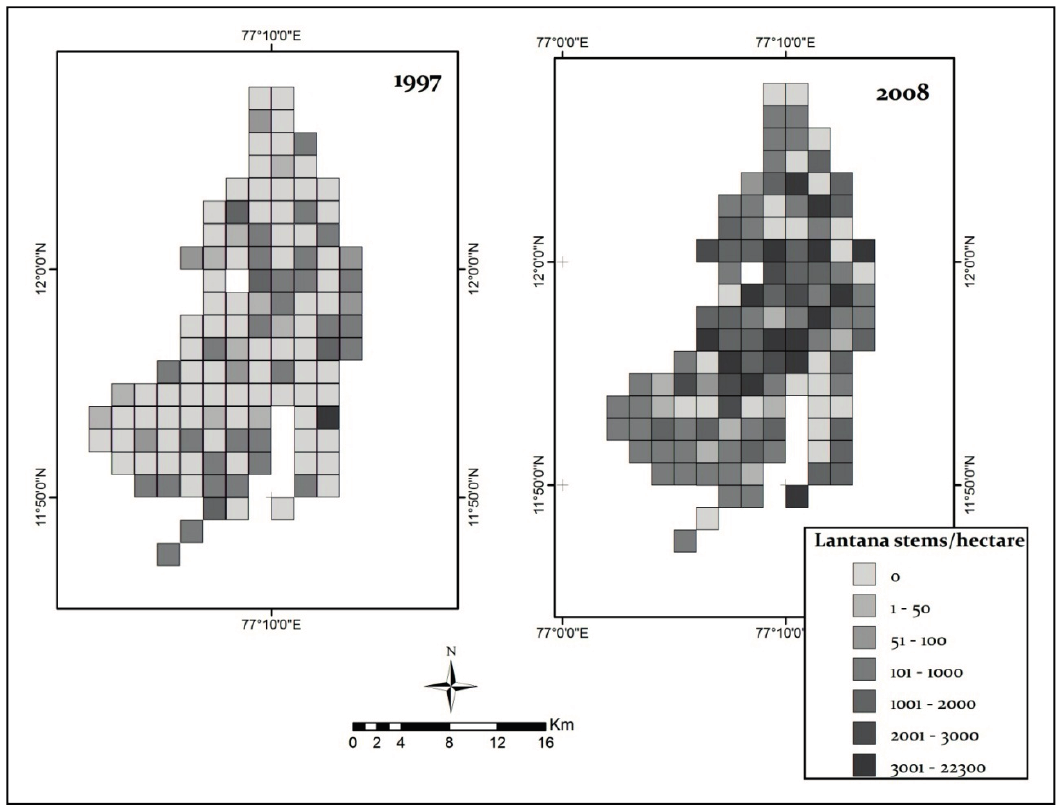
Figure 6. Lantana camara spread in Biligiri Rangaswamy Temple Tiger Reserve (BRT) over a period of one decade. Map source: Hiremath and Sundaram 2014. Reproduced with permission from